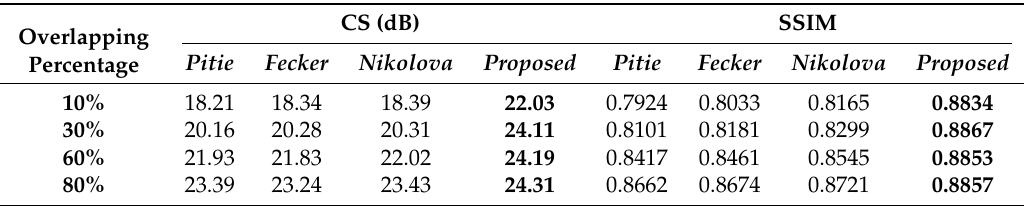
Table 1. Comparison for synthetic dataset (average of 40 image pairs for each overlapping